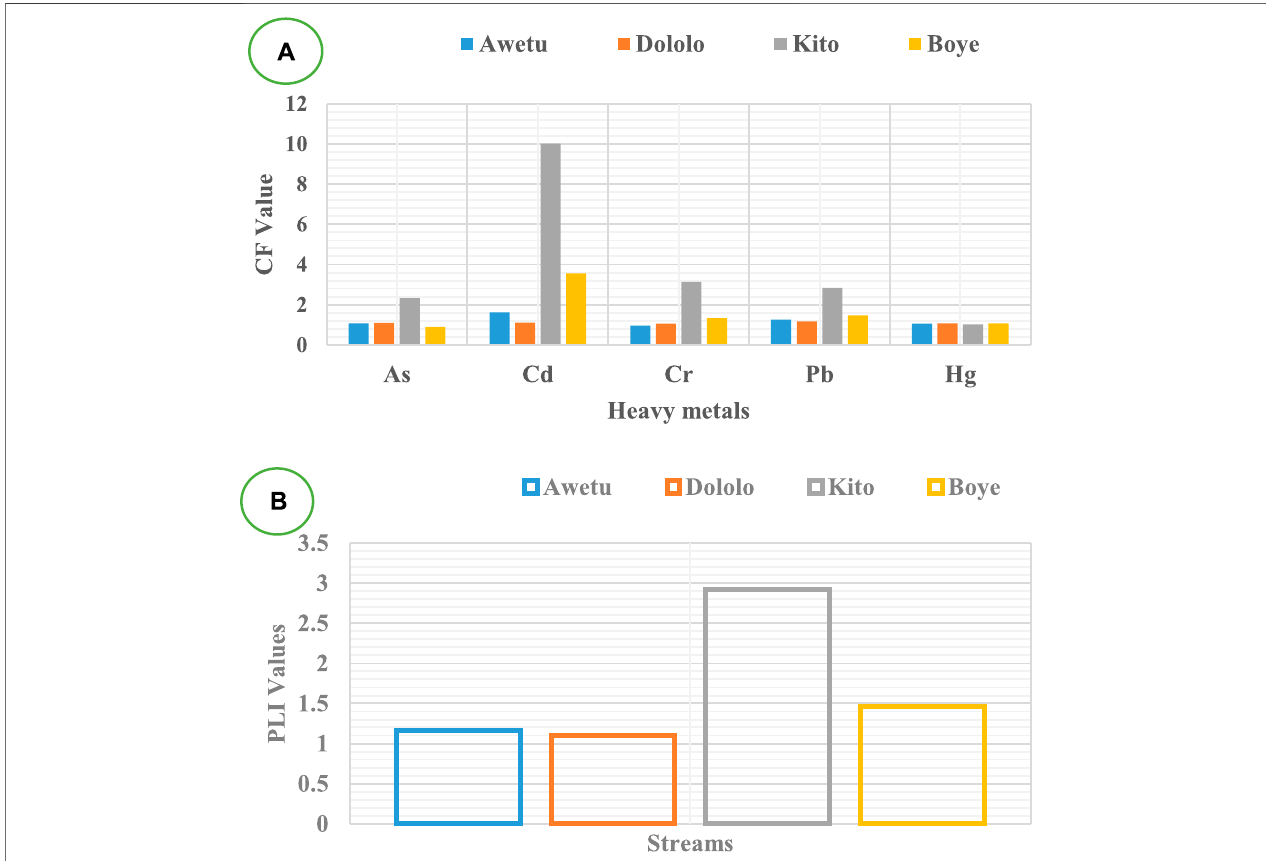
Frontiers in Earth Science |